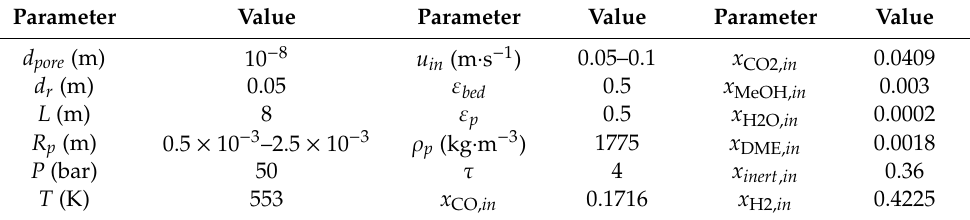
Table 1. Main values of the model parameters employed in numerical simulations [4–6,11,12].